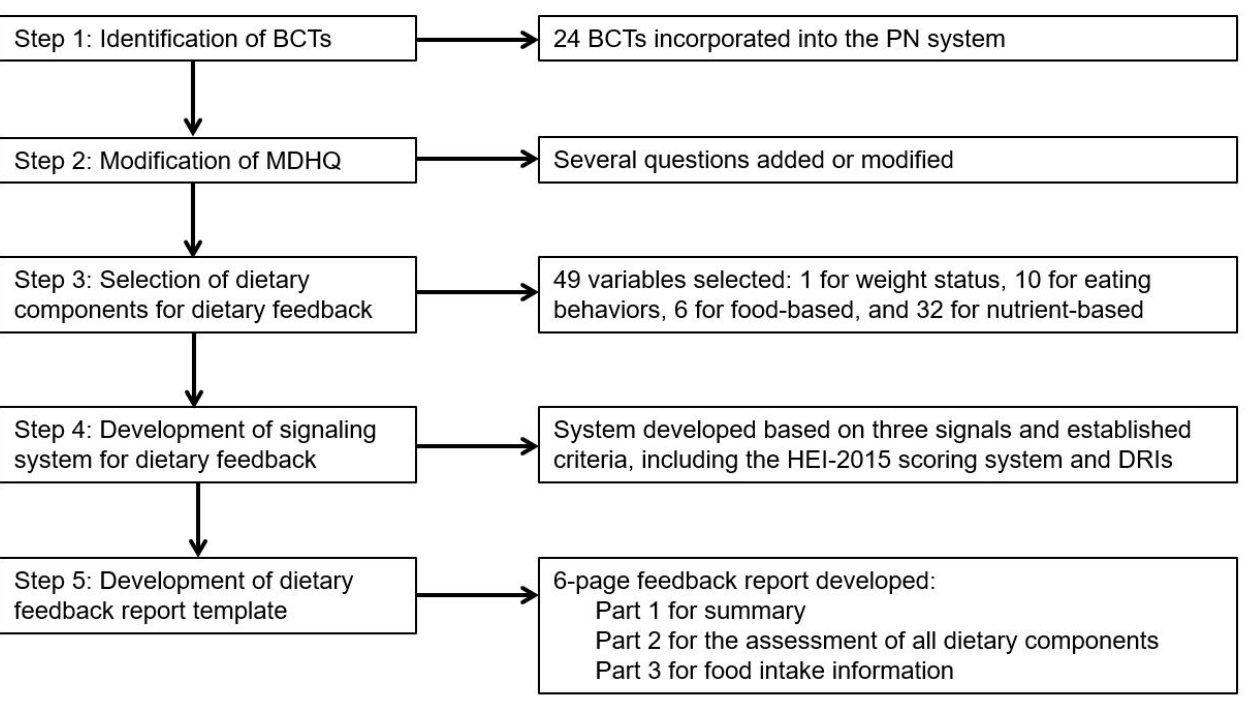
Figure 1. A summary of the development process of the personalized nutrition (PN) system. BCTs, behavior change techniques; DRIs, Dietary Reference Intakes; HEI-2015, Healthy Eating Index-2015; MDHQ, Meal-based Diet History Ques- tionnaire.